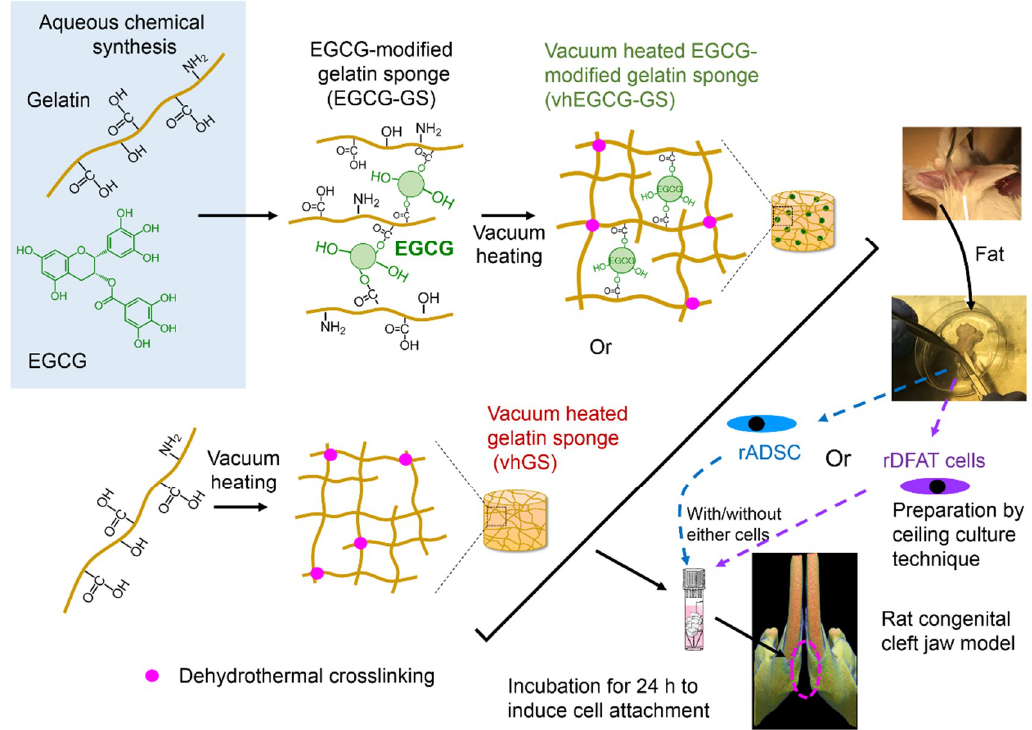
Figure 1. Scheme showing the workflow for the preparation of sponges and cell transplantation. rADSC: rat adipose-derived stem cells; rDFAT cells: rat dedifferentiated fat cells; ECGC: epigallocatechin gallate.